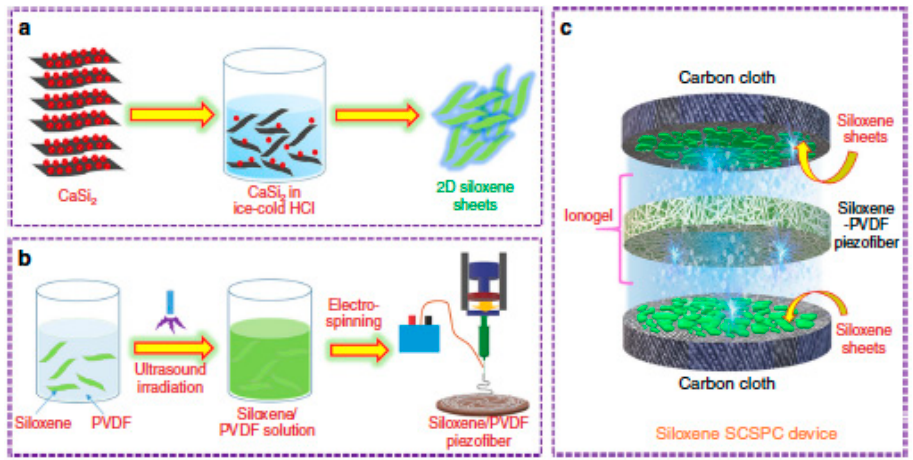
Figure 22. Schematic representation of steps involved in the fabrication of siloxene self-charging supercapacitor power cells (SCSPC). ( a ) represents the preparation of siloxene sheets via topochemical deintercalation of calcium from CaSi 2 in the presence of ice-cold HCl solution, ( b ) represents the fabrication process involved in the electrospinning of siloxene/PVDF piezo fibers, and ( c ) indicates the fabrication of a siloxene SCSPC device using siloxene sheets-coated carbon cloth as two symmetric electrodes and electrospun siloxene–PVDF piezo fibers impregnated with ionogel electrolyte as the separator. Reprinted with permission from [156].